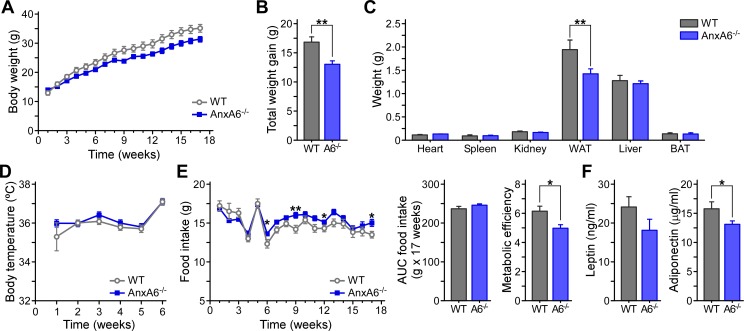
Reduced weight gain and less adiposity of AnxA6-KO mice after HFD feeding.8 weeks old male WT and AnxA6-KO (AnxA6-/-, A6-/-) C57BL/6J mice were fed a high fat diet (HFD) for 17 weeks. (A) Weekly weight gain over the 17 week HFD feeding period. (B) Cumulative weight gain after 17 week HFD feeding (mean ± SEM, n = 25–27). (C) Organ weight comparison after 17 week HFD feeding. AnxA6-KO mice had significantly less white adipose tissue (WAT; epididymal + subcutaneous WAT) than WT mice (mean ± SEM, n = 7–8 for heart, spleen, kidney, BAT; n = 14 for WAT; n = 22 for liver). Brown adipose tissue (BAT). (D) Body temperature over 6 weeks HFD feeding (mean ± SEM, n = 14). (E) Food intake over the HFD feeding period. AnxA6-KO mice consumed slightly more in week 6, 9, 12, and 17, but the area under the curve (AUC) of total food intake over the 17 week HFD feeding period was comparable. The metabolic efficiency (% food stored as body weight) was reduced in AnxA6-KO mice (mean ± SEM, n = 14). (F) Serum from HFD-fed WT and AnxA6-KO mice was analyzed for leptin and adiponectin levels using ELISA as described (mean ± SEM, n = 14). ** P < 0.01, * P <0.05 (Student’s T-test).